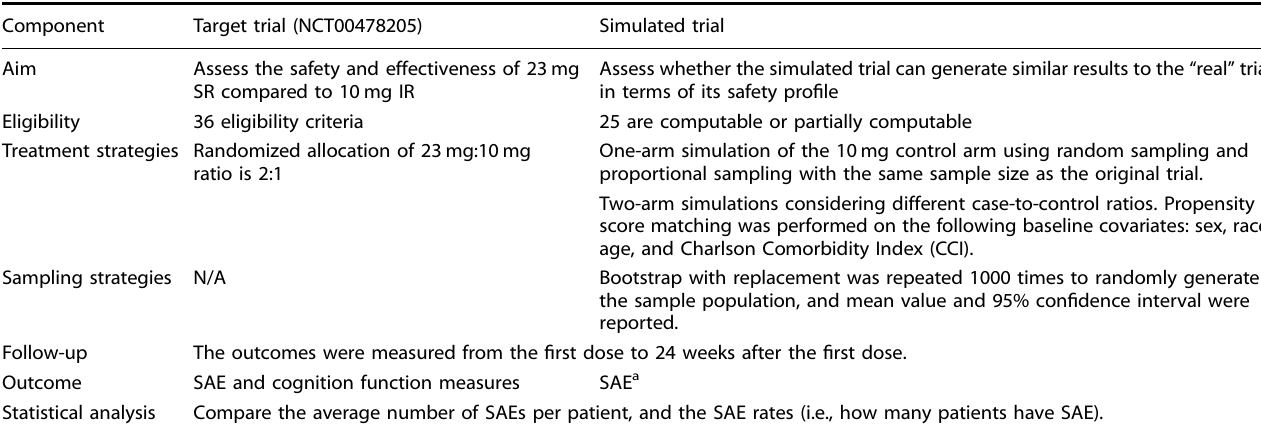
Table 4. Overall study design of the simulated trial in comparison with the original